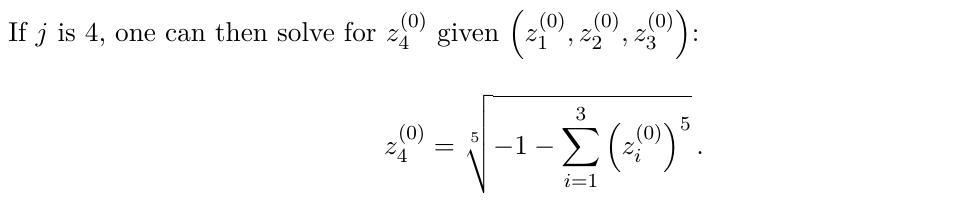
If j is 4 , one can then solve for z (0)